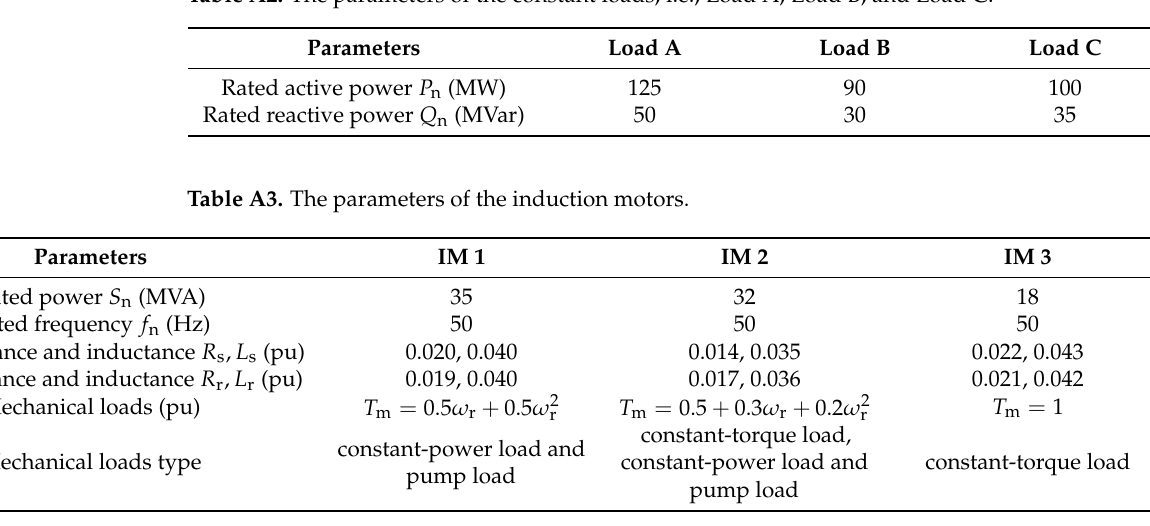
Table A2. The parameters of the constant loads, i.e., Load A, Load B, and Load C.